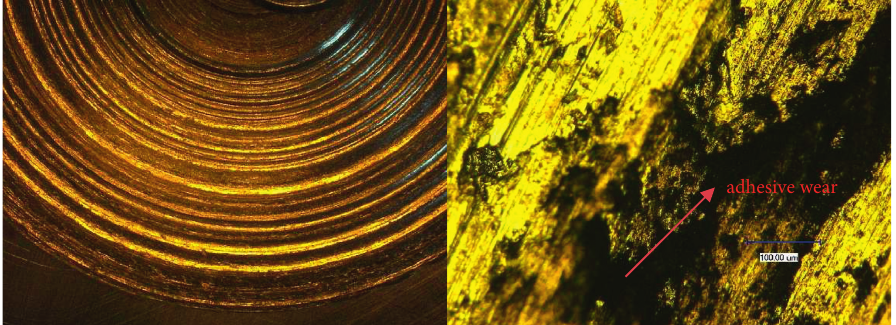
Figure 12: Dry grinding morphology of the smooth sample.